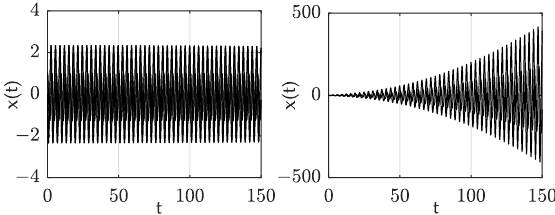
Figure 8. Response of point F, with F = 0 ( left ) and F = 1 ( right ).